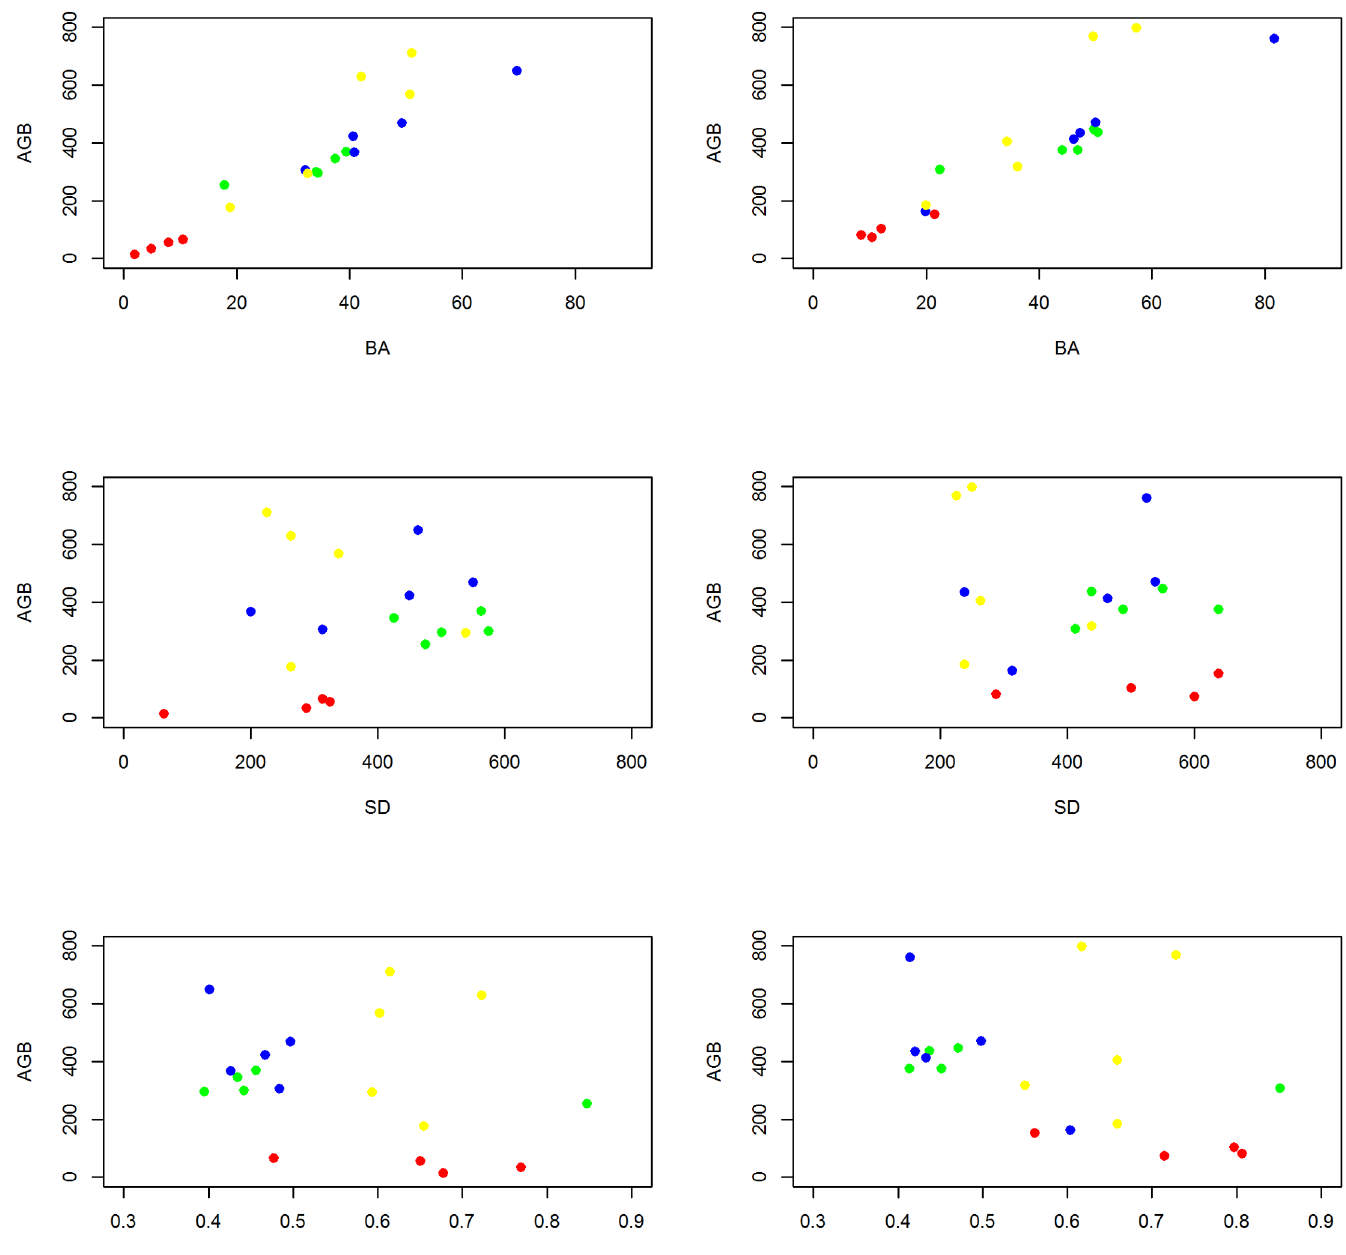
Fig 5. Above ground biomass (AGB in Mg ha -1 ), in relation to basal area (BA in m 2 ha -1 ), stem density (SD in number stems ha -1 ) and wood mass density weighted by BA (WMD) in 1993 (left) and 2013 (right). Red: colonising forest (F1), green: monodominant Okoume forest (F2), blue: young Marantaceae forest (F3) and yellow: mixed Marantaceae forest